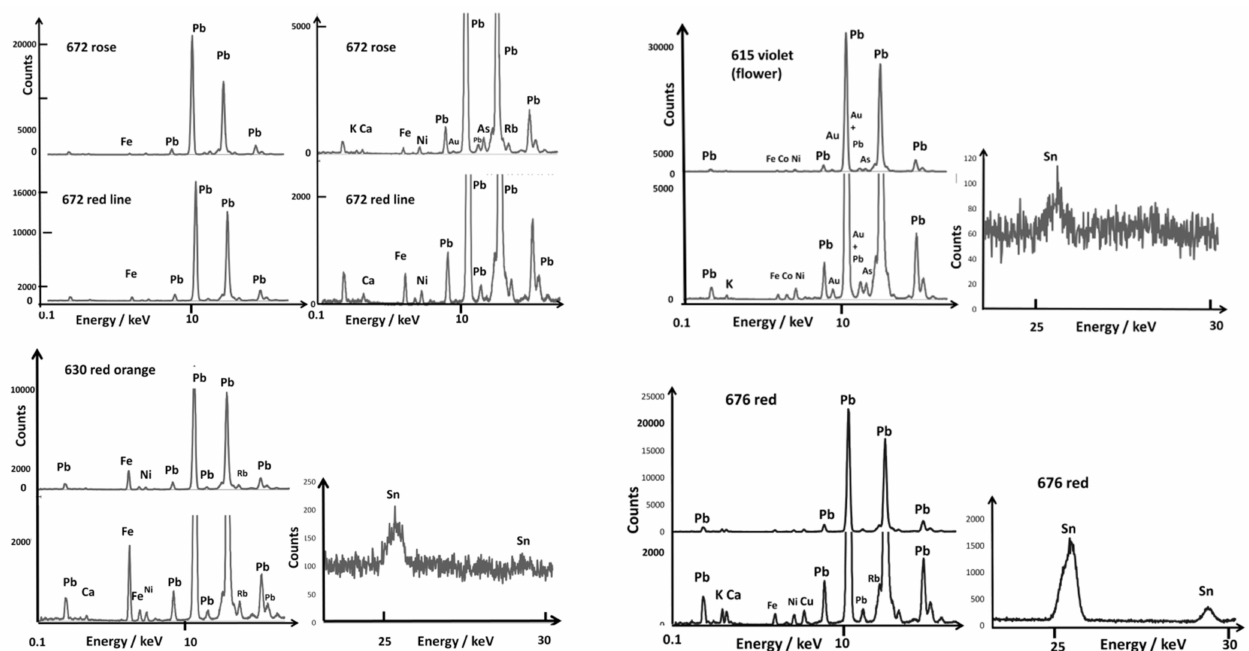
Figure 8. Comparison of representative XRF spectra for rose, red, and violet colors recorded in the 0.1–20 and 20–30 keV energy